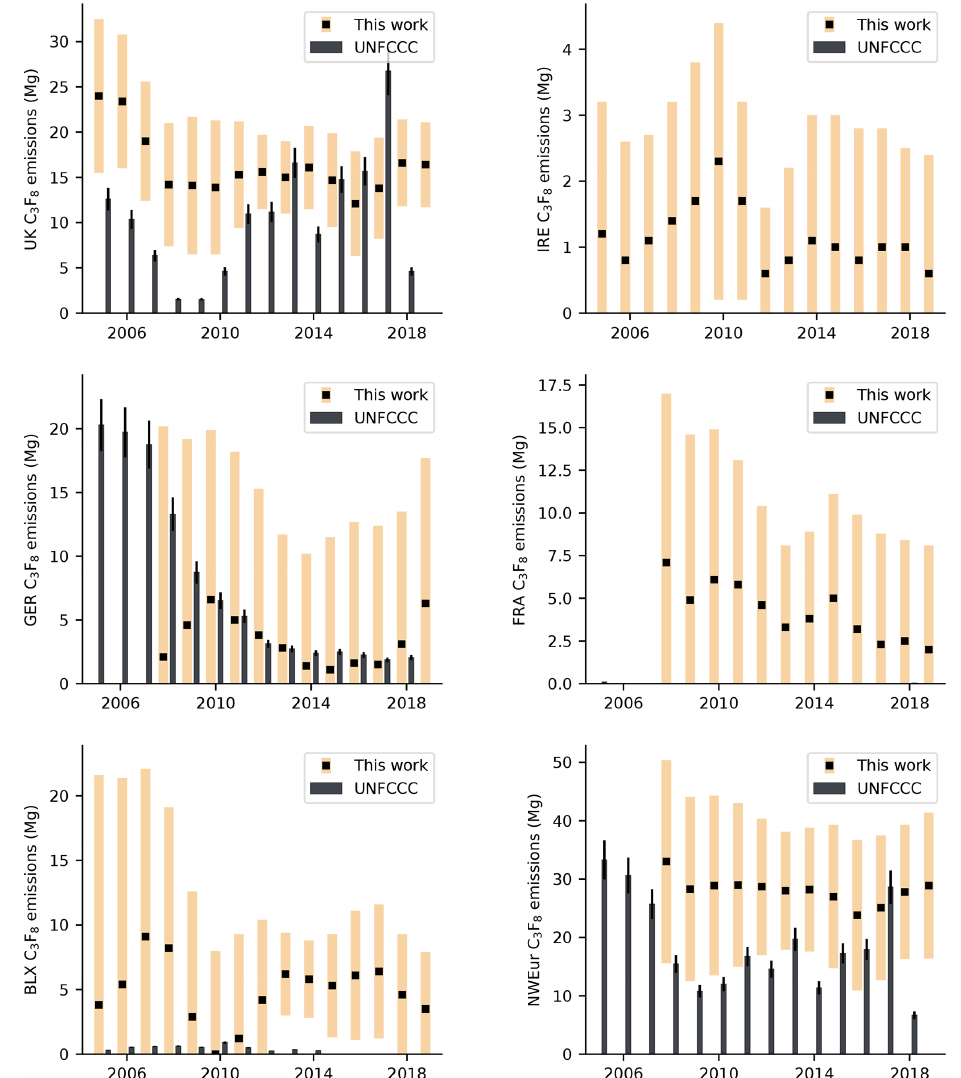
Figure 9. Annual C 3 F 8 emissions (2005–2019) for northwest European countries in Mgyr − 1 . InTEM estimates are shown as black squares with pale orange uncertainty bounds. Emissions reported to the UNFCCC (sum of individual reporting countries) are shown as black bars, with an assumed uncertainty (black error bars) of 10%. Note that UNFCCC data are only available up until 2018